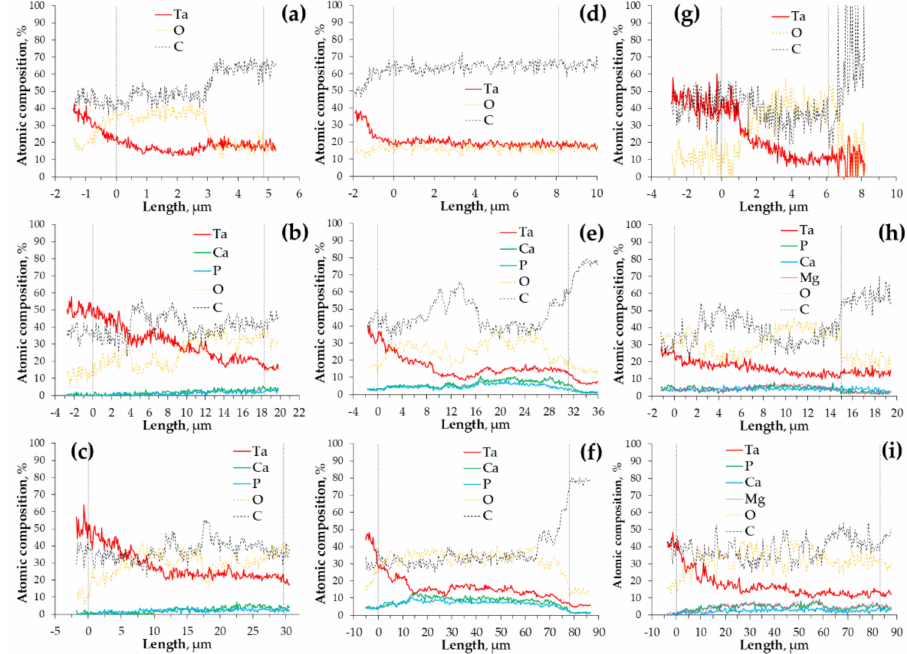
Figure 3. EDX line scans performed on the cross-sectional SEM images of Ca1P2 ( a – c ), Ca5P3 ( d – f ) and (CaMg)5P3 ( g – i ); and treated up to the limiting voltages: 200 V ( a , d , g ), 300 V ( b , e , h ) and 400 V ( c , f , i ); refer to Figure 2 to see the paths of the line